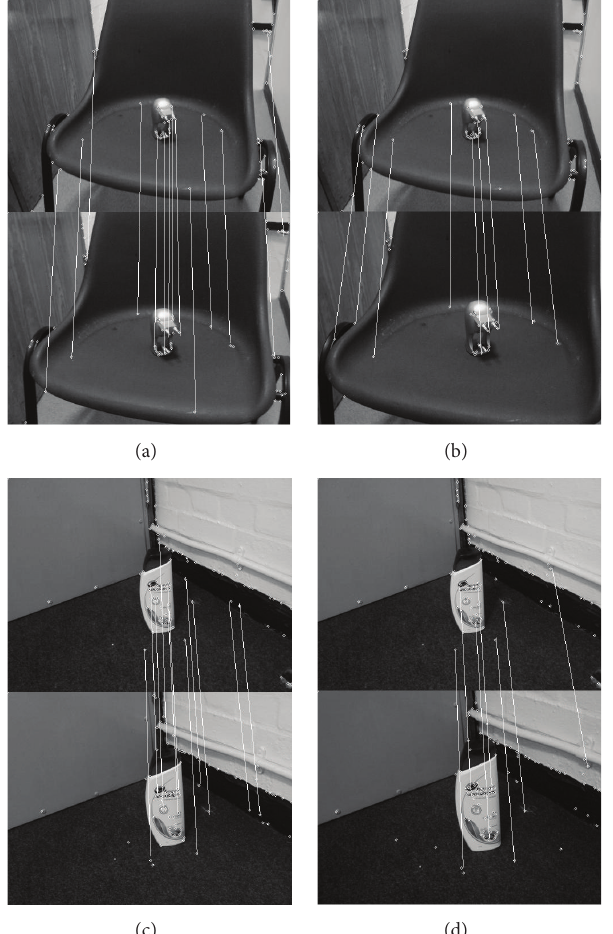
Figure 6: Scaled image pairs matched using FAB descriptor. Reference image in Figure 5 is matched with corresponding test